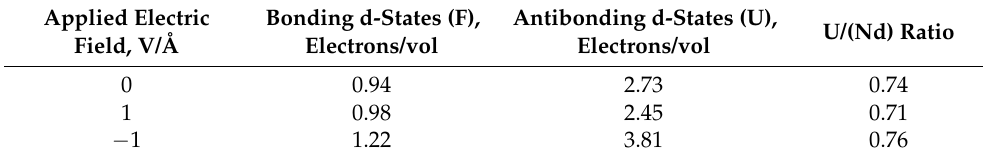
Figure 4. Partial density of states (PDOS) of ( a ) Y-cation, ( b ) O terminal and, ( c ) O sublattice labeled as A, B and C respectively on the schematic shown on the right, at three different field values of 0, +1, and − 1 V/Å. Table 1. Quantification of the bonding (below the Fermi energy) and antibonding (above the Fermi energy) PDOS d-states of a Y-cation for applied electric field values of 0, +1, and − 1 V/Å.